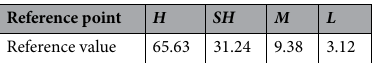
Table 2. Reference points and values for AR .